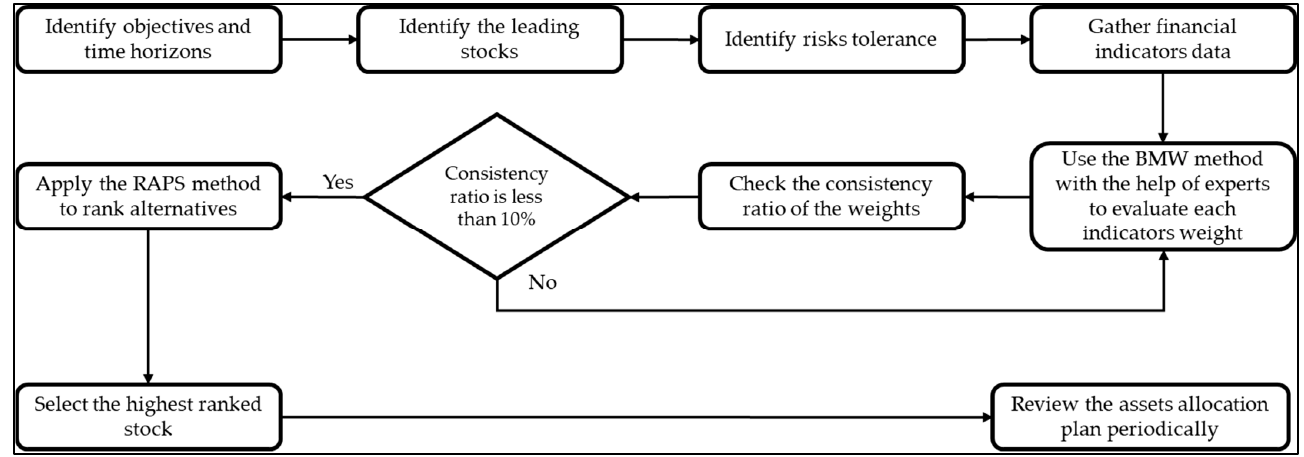
Figure 1. Asset allocation process used for the proposed method.